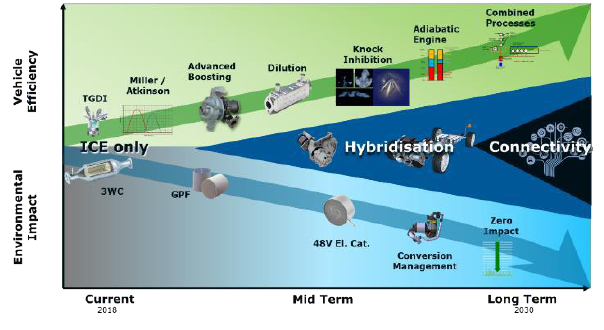
Fig. 11. Technology roadmap Gasoline